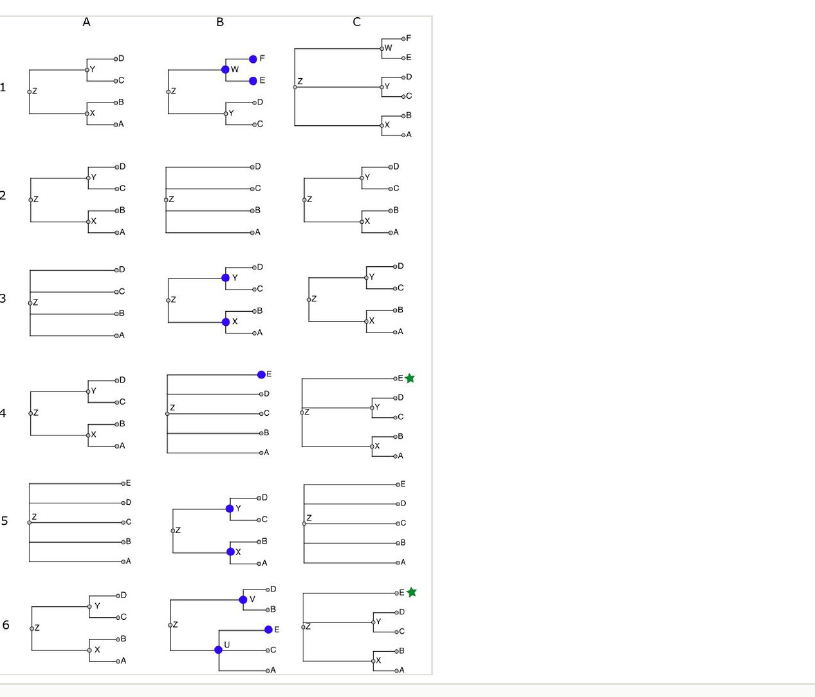
Merging taxonomies: Examples of outcomes when merging nodes from a source taxonomy into the workspace taxonomy. Each row (1-6) corresponds to one of the six examples described in the text. Column A is the current workspace taxonomy, column B is the source taxonomy being merged, and column C is the resulting workspace taxonomy. Nodes in B marked with a large blue circle are those that cannot be aligned to the workspace. Nodes in C marked with a green star are those fl agged as incertae sedis in the fi nal